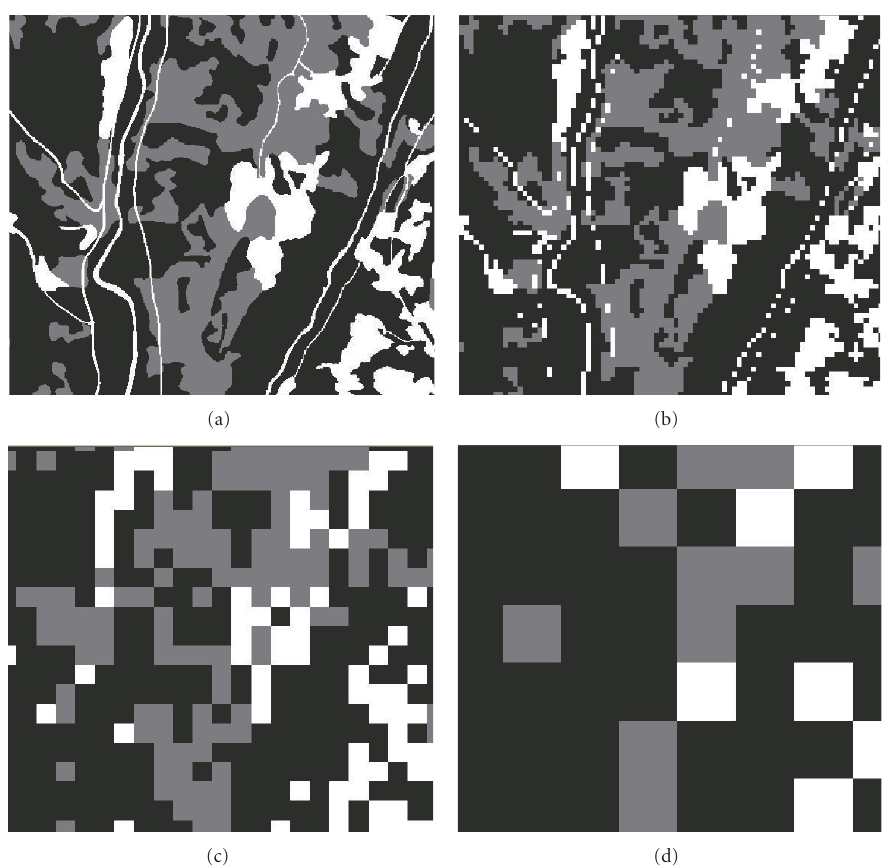
Figure 4: Landscape matrix-grid in a portion of the Montmorency Forest, with varied grain. Map grain = 5m (a), map grain = 25m (b), map grain = 100 m (c) and map grain = 300 m (d). White: open area, light grey: young forest and dark grey: mature